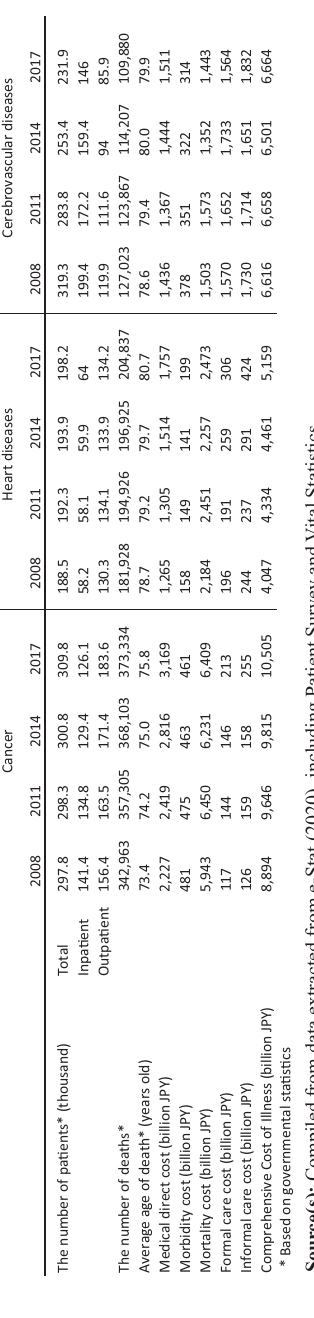
Table 2. An overview of the results: the Comprehensive Cost of Illness, the number of patients, the number of deathsandaverageage of death of three major